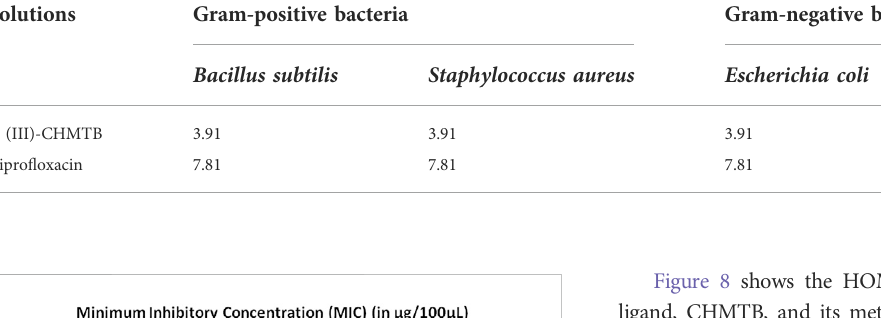
TABLE 9 Minimum inhibitory concentration (MIC) (in μ g/100 μ L) of Ir (III)-CHMTB complex.